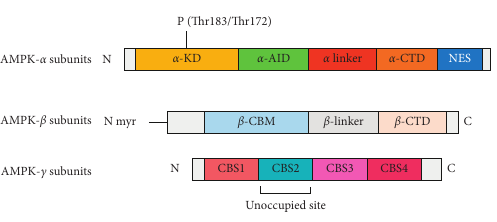
Figure 1: The structure of AMPK subunits: AMPK have three subunits, including α , β , c . α is catalytic while β and c are regu- latory. Both α 1 and α 2 subunits have a crucial site in Thr183 and Thr172, whose phosphorylation is necessary for AMPK maximal activation. The β subunits could act as a scaffold, which makes the AMPK complex located on lysosomes, an exception from having phosphorylation, myristoylation, and carbohydrate-binding sites. The c subunits bind the nucleotides by three sites, which are the structural basis for this energy